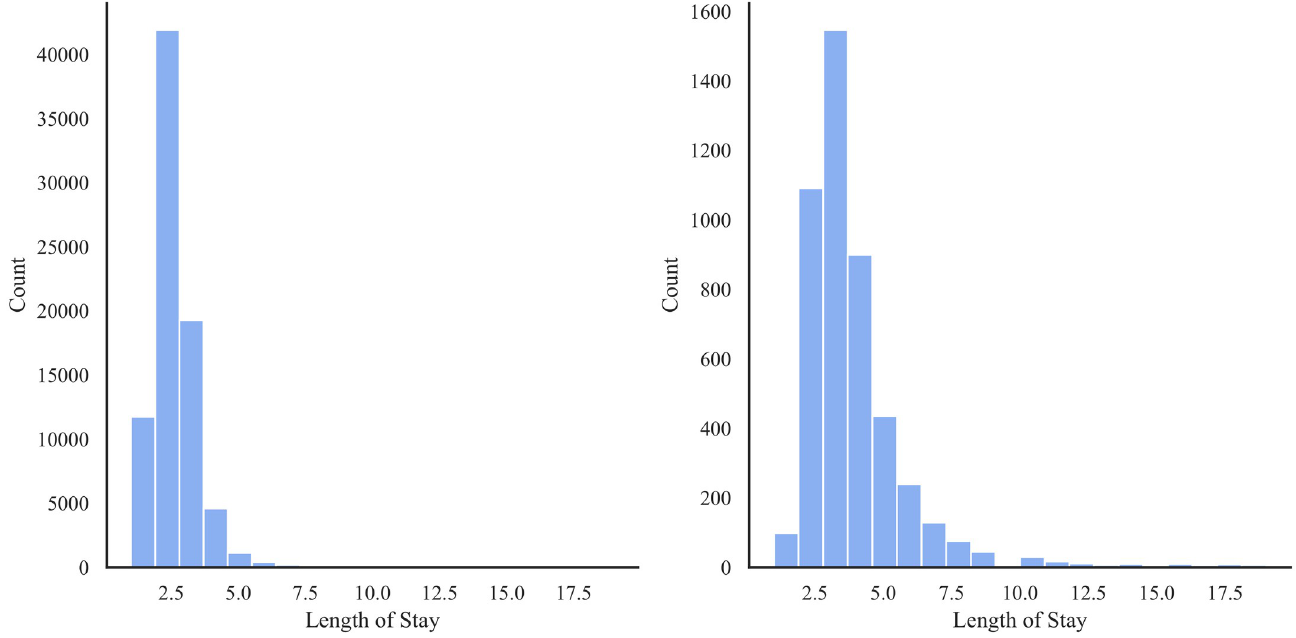
Fig 7. Distribution of length of stay—Left: Women without PE; Right: Women with PE.